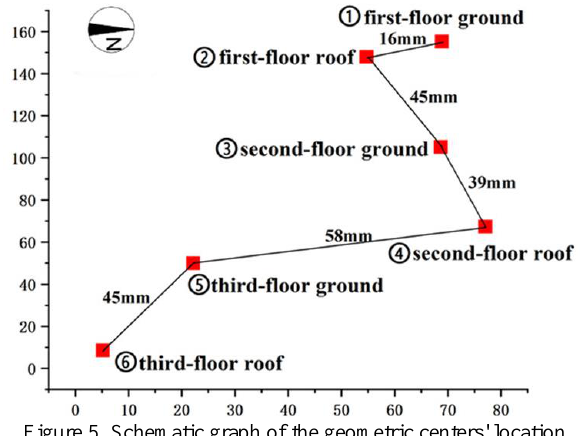
Figure 5. Schematic graph of the geometric centers' location Figure 5 shows the horizontal projection of the geometric center. Points 1 to 6 represent six geometric centers. The distance marked in the figure is the projection distance of the geometric center on the horizontal plane, and the upper left corner is a compass which indicates the tilted direction of the geometric center. The following conclusions can be drawn from figure 5: (1) The first floor and the third floor of Guanghua Pavilion [ 光 化楼 ] are tilted to the southeast direction, and the second